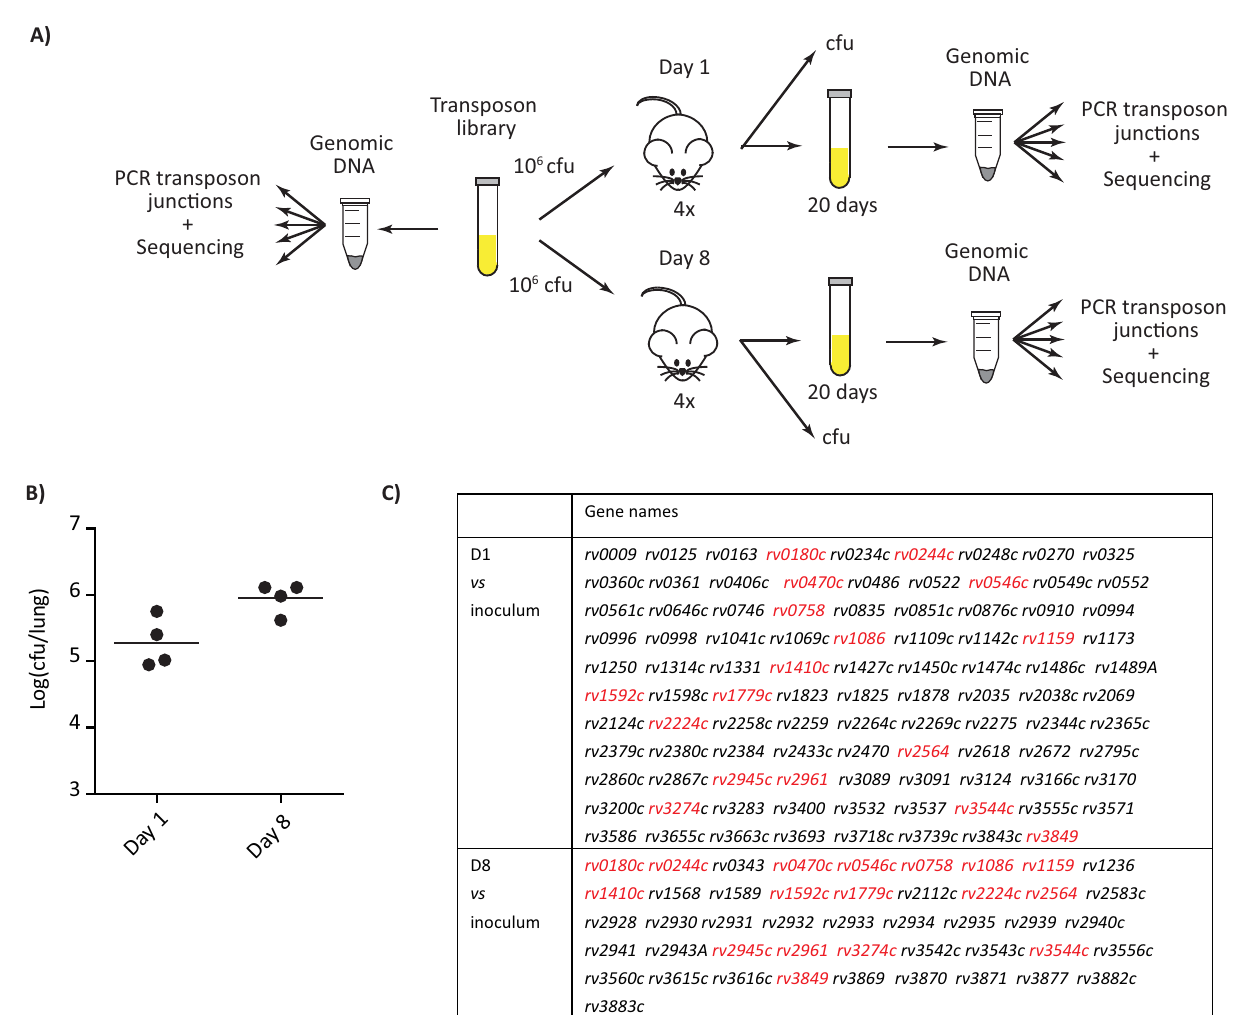
Fig 1. Identification of genes required for M . tuberculosis seeding in the lung of mice. (A) Scheme of the TnSeq strategy used. BALB/c mice were infected intranasally with 10 6 cfu of our H37Rv-derived transposon library. At 1 day and 8 days post-infection, four mice were sacrificed. Part of the lung and spleen homogenates were plated to evaluate bacterial load. The remaining part of the organ homogenates was used to inoculate a culture used for DNA extraction, transposon-junctions amplification and TnSeq analysis. (B) Bacterial load in the lung of mice after 1 and 8 days. Each dot corresponds to a different mouse and the mean of the four mice is indicated. (C) Genes in which insertion were underrepresented in mice after 1 or 8 days of infection in comparison to the inoculum. The list reports only the gene detected both using the ESSENTIAL and TRANSIT softwares; in red, the genes common to the two time